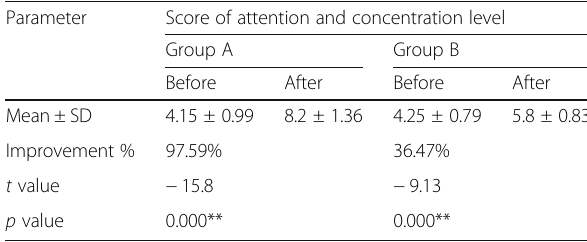
Table 1 Comparison of mean scores of attention and concentration level pre and post treatment within each group Parameter Score of attention and concentration level Group A Group B Before After Before